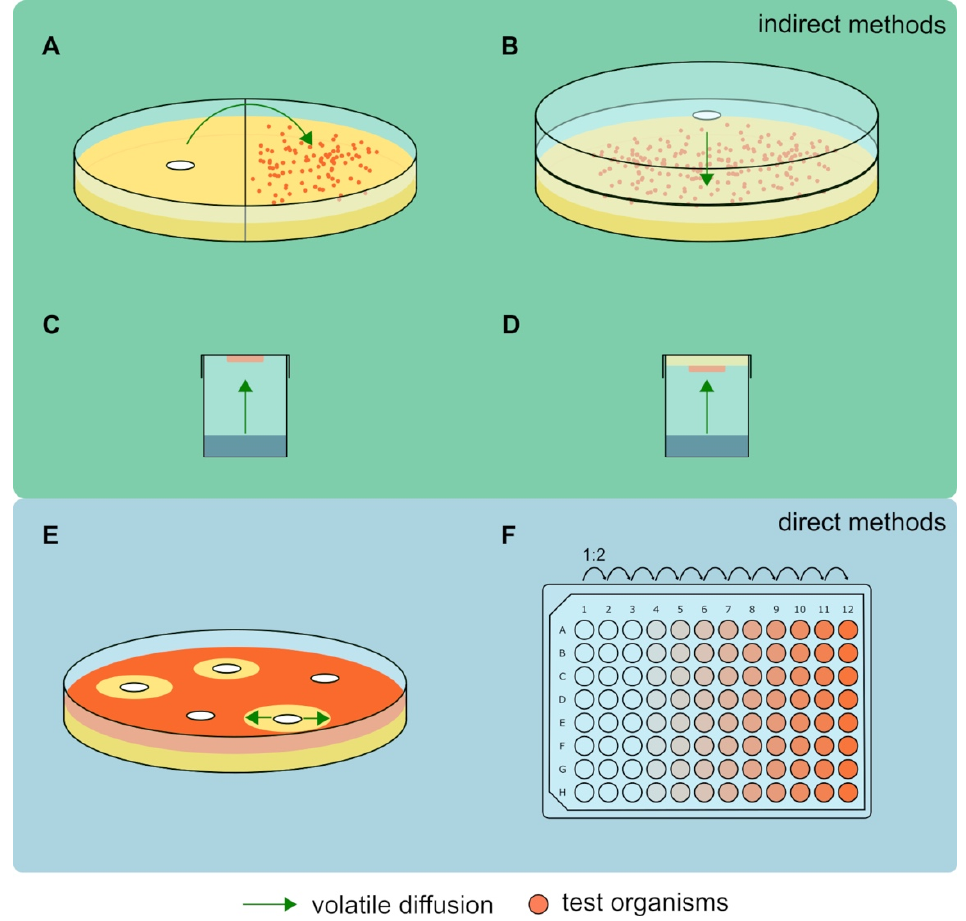
Figure 2. Overview of indirect ( A – D ) and direct ( E , F ) approaches to test the antimicrobial activity of volatiles. Indirect approaches such as the two-chamber Petri dish ( A ), double plate ( B ), vial ( C ) and AntiBio Vol approach ( D ) compel the volatiles to diffuse through the gas phase to reach the test organisms. In contrast, direct approaches such as the agar diffusion approach ( E ) and the minimal inhibitory test ( F ) allow direct contact between the volatiles and test organisms. Details are described in the main text.